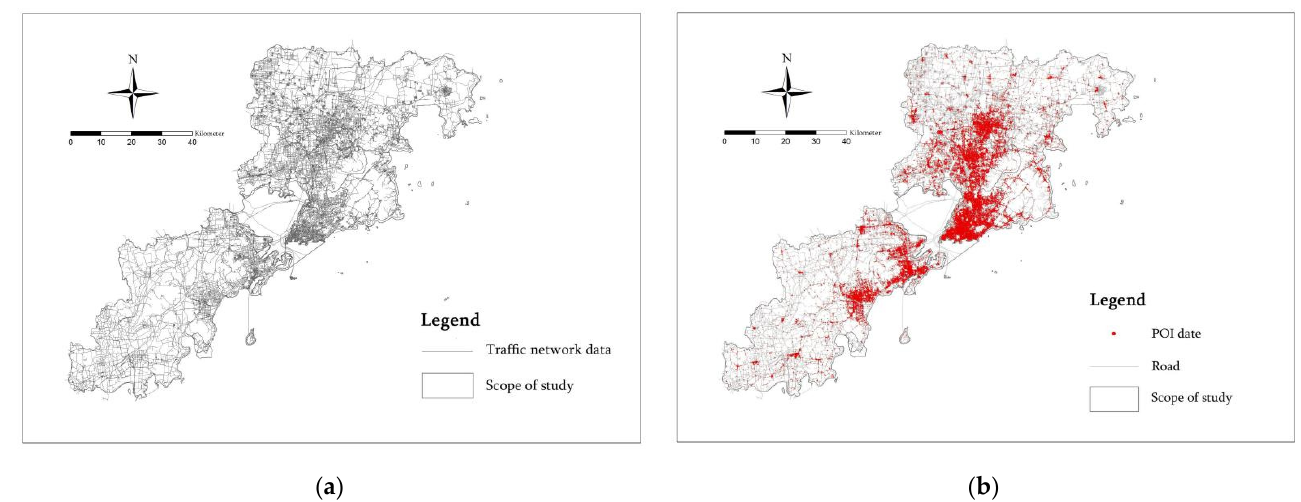
Figure 5. ( a ) Traffic network data and ( b ) POI infrastructure data for the seven municipal districts of Qingdao. Table 2. Classification of POI data for seven municipal districts of Qingdao.